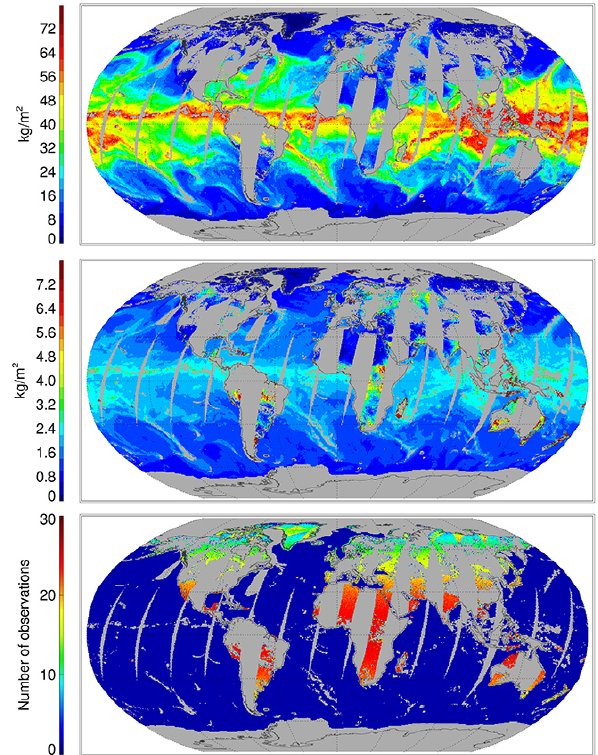
Figure 1. Example of daily composite of TCWV (top), associ- ated uncertainty (middle) and number of observations used (10 May